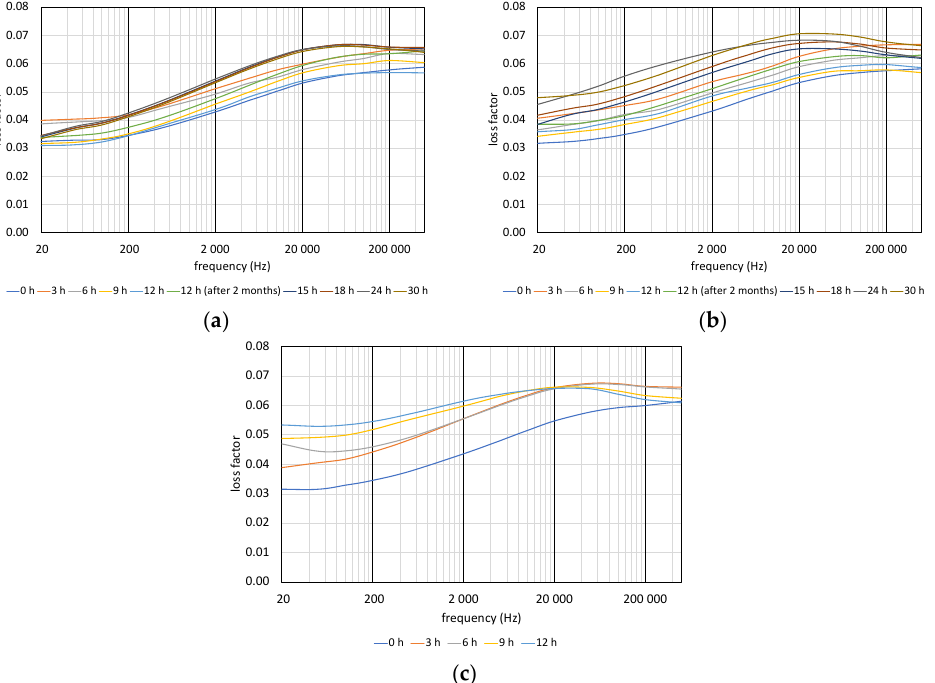
Figure 7. Changing of loss factor with aging time: ( a ) 110 °C, ( b ) 125 °C, ( c ) 140 °C.